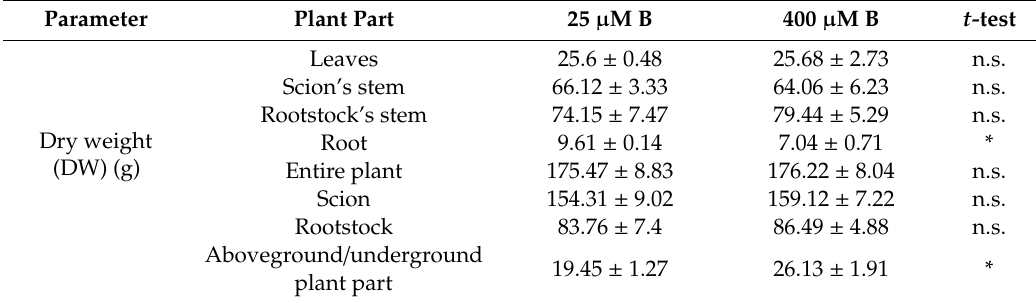
Table 1. E ff ects of B concentration in the nutrient solution (25 or 400 µ M) on various growth parameters of apple plants, based on dry weight (DW) measurements.